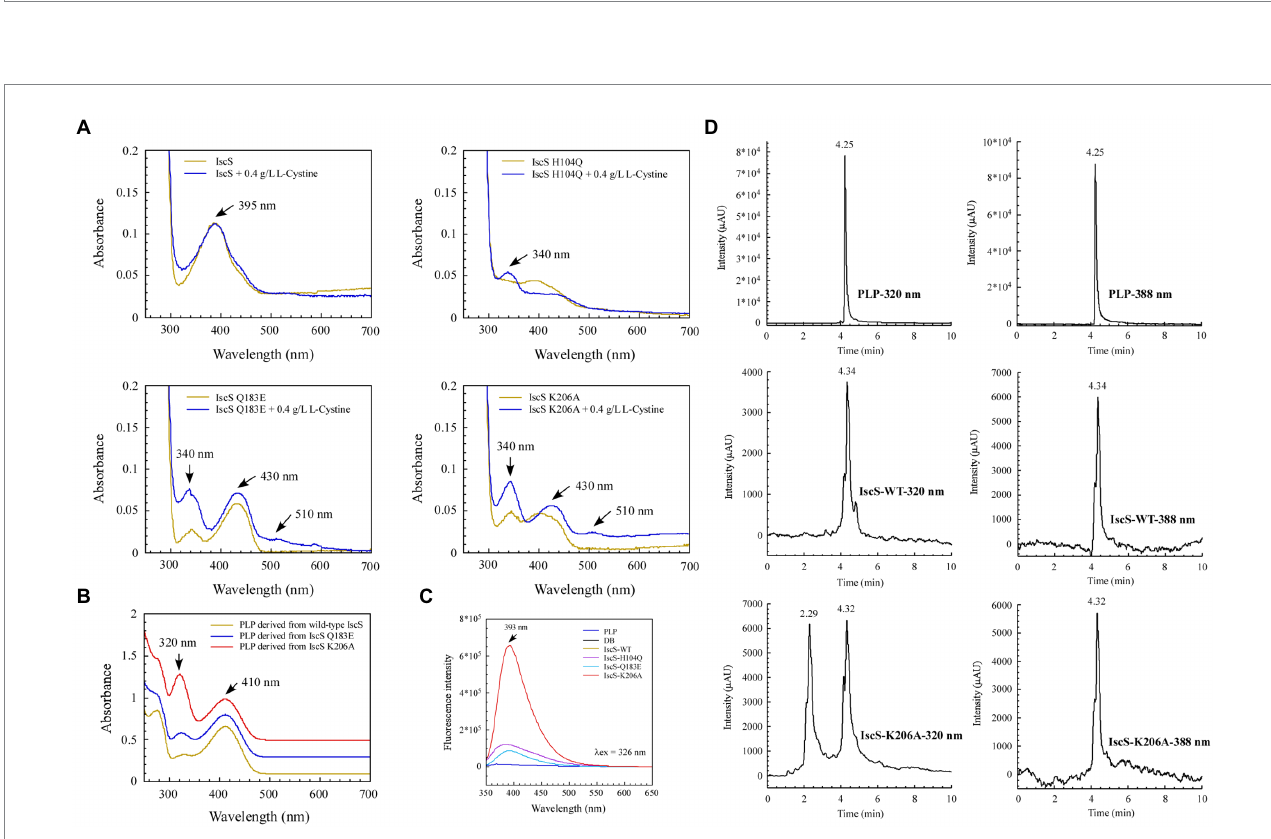
FIGURE 8 Isolation and identification of suspected intermediates from the enzymatic reaction of IscS. (A) UV–visible spectra of purified IscS-WT and its variants (25 μ M) are expressed in the BL21(DE3) cells, with or without L-cystine. When the Escherichia coli cells grown in LB media reached OD 600 of 0.6, the recombinant CDs were induced with 0.02% arabinose for 3 h at 37 ° C. Then, the cells were collected by centrifugation and resuspended in an equal volume of M9 basal media. Chloramphenicol (34 μ g/ml) was added, with or without L-cystine (0.4 g/L). After incubation at 37 ° C for 3 h, the cells were collected for purified recombinant CDs; (B) UV–visible spectra of the supernatant of desalted IscS-WT and IscS variants after heating at 100 ° C for 10 min; (C) Fluorescence spectra of PLP and its derivatives derived from IscS-WT and IscS variants. The sample preparation method was the same as that of (B) ; the concentration was about 100 mM. The excitation wavelength was set at 326 nm; (D) HPLC profiles of PLP standard (100 μ M) and PLP derived from wild-type IscS and IscS K206A. Chromatography was performed using an Agilent 1260 Infinity HPLC system. The chromatographic separation was performed on an Ecosil C18-AQ PLUS column (4.6 mm × 250 mm, 5 μ m) with a mobile phase consisting of acetonitrile and ammonium acetate buffer (10 mM, pH 5.6; 30:70, v/v) at a flow rate of 0.5 ml/min. The temperature of the column was maintained at 25 ° C. The injection volume was 10 μ l. The UV detection wavelength was set at 320 and 388 nm,